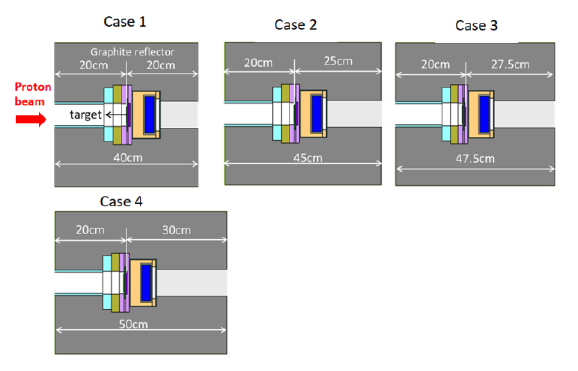
Fig. 6. Four cases of graphite reflector dimension The cold neutron intensity was evaluated with respect to the reflector dimensions. Case 1 is the current RANS graphite dimension with 20 cm-thick in both forward and backward direction from the neutron production target.